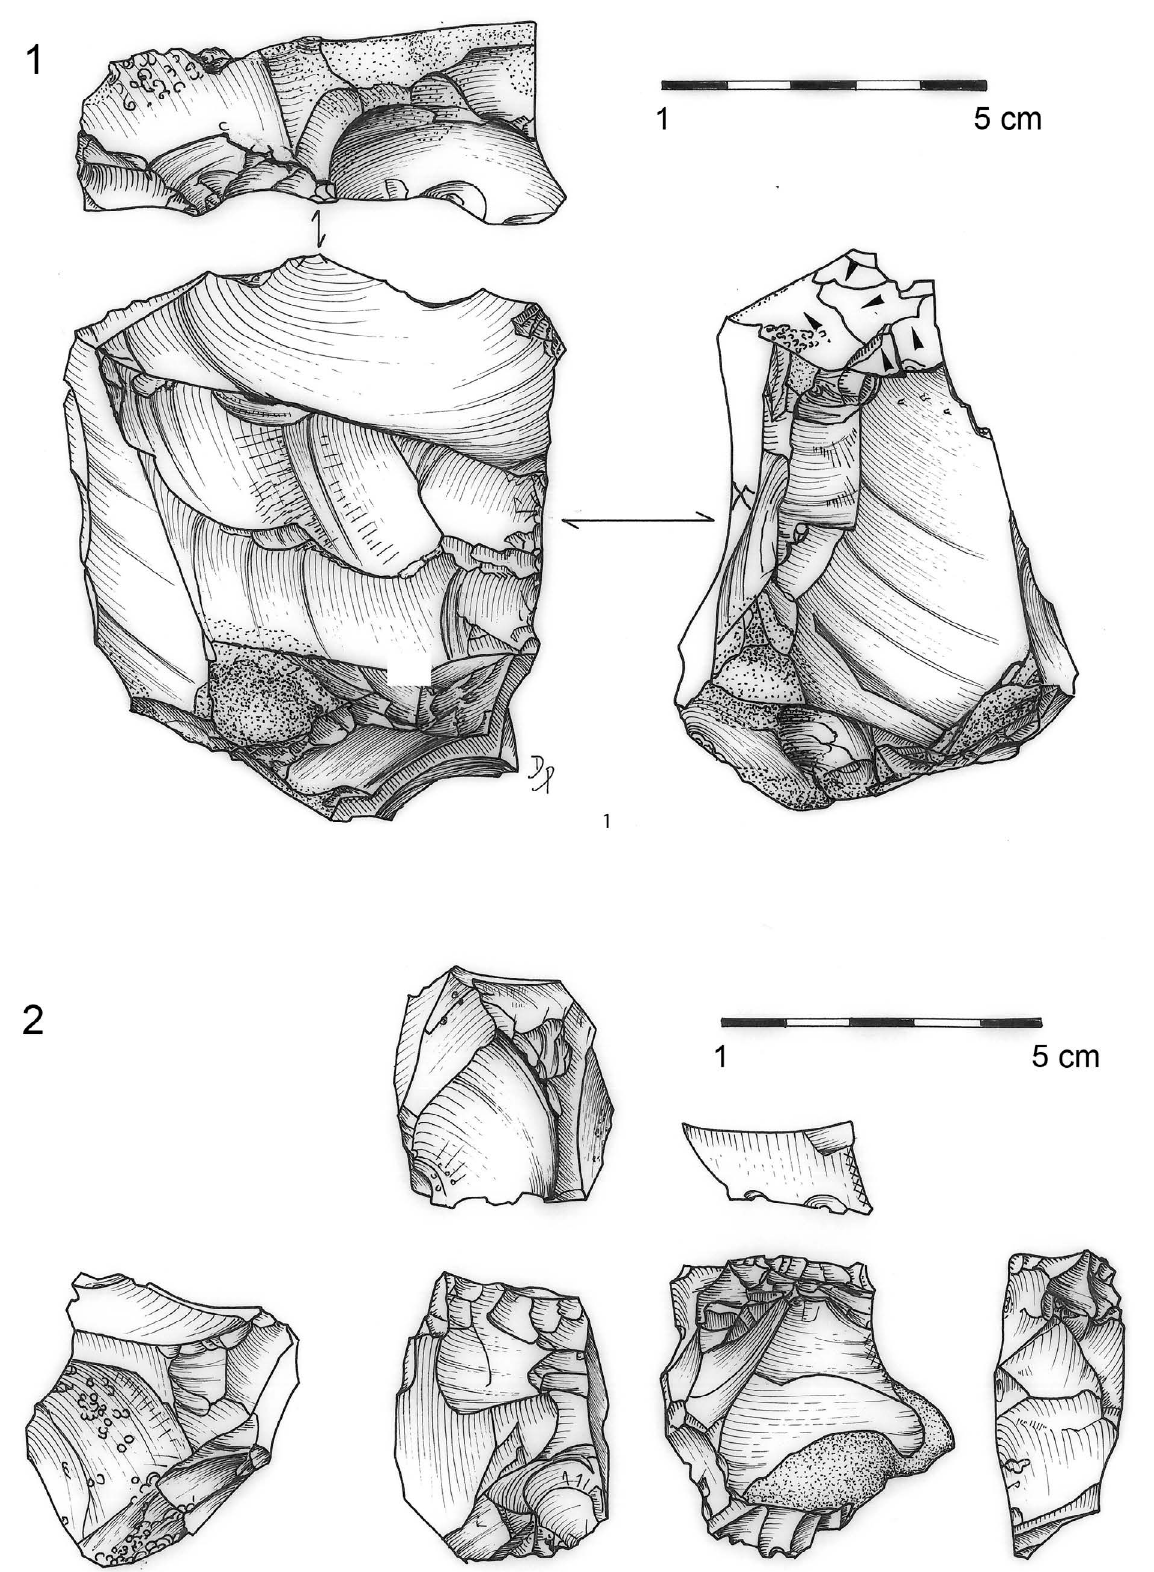
Figure 5. Nucléus à éclats du site de Saint-Pierre-d’Autils « Le Plaquis » (Eure). 1, nucléus multidirectionnel. 2, polyèdre. Dessin de D. Prost. Figure 5. Flake cores from Saint-Pierre-d'Autils site. 1, multidirectional core. 2, polyhedron core. Drawing by D.